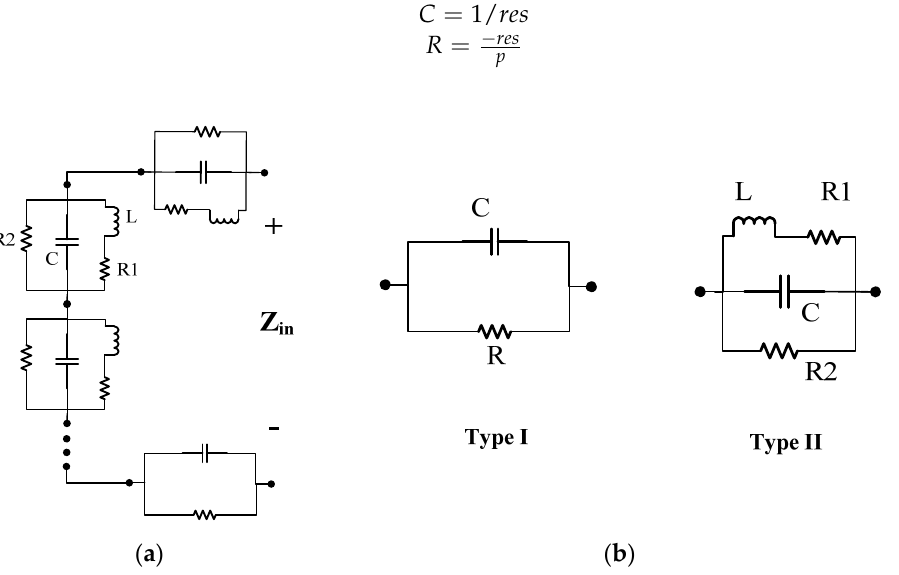
Figure 8. Forms of circuit model for impedance: ( a ) entire circuit model; ( b ) basic sub-circuit model.